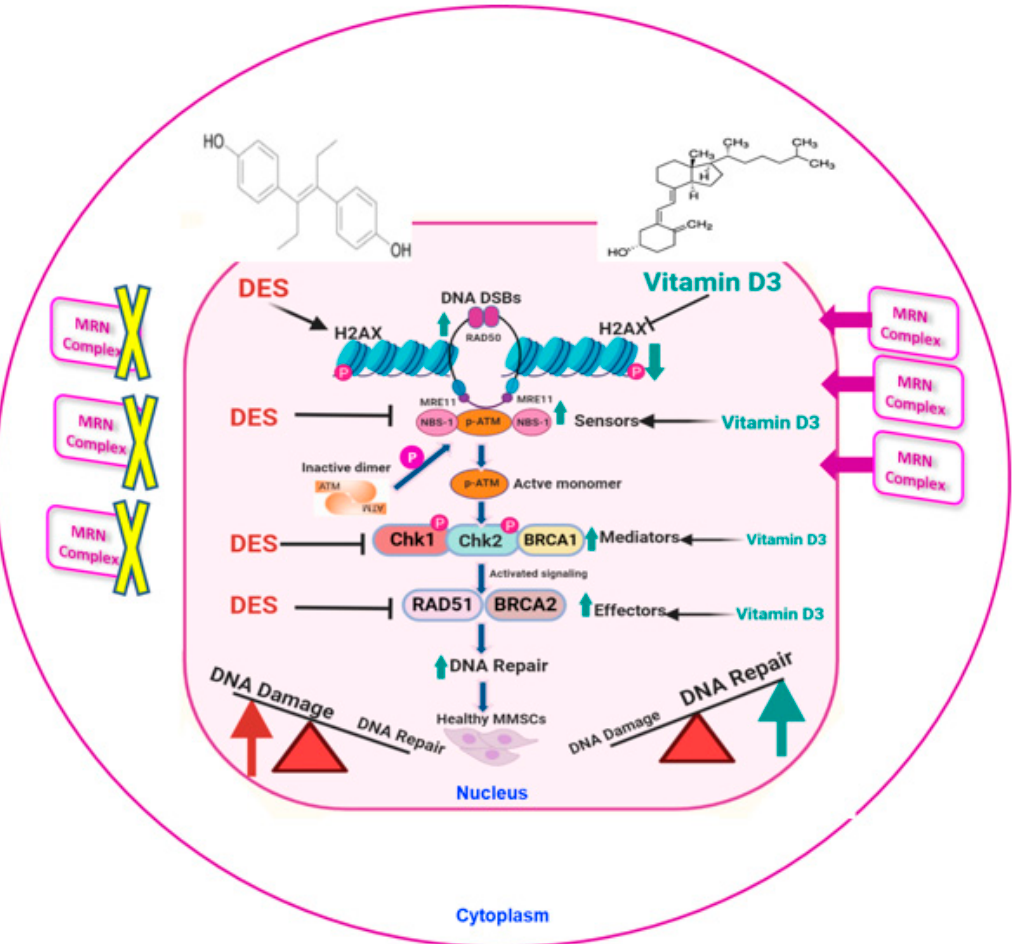
Figure 7. Working model of the relationship between DES-induced DNA damage and the effect of VitD3. Developmental exposure to DES enhances DNA damage load, as demonstrated by increased levels of the DNA damage marker γ -H2AX, and is concomitant with decreases in protein levels of key DNA repair components, including the MRN complex (degraded in the cytoplasm), mediators, and effectors. VitD3 treatment is capable of reversing the action of DES by recovering DNA damage repair capacity through increasing the translocation of the nuclear protein levels of DNA repair proteins, including RAD50, MRE11, and NBS1, as well as effectors and mediators including Chk1, Chk2, BRCA2, and RAD51, thus enhancing the DNA damage repair response. This figure was created with BioRender.